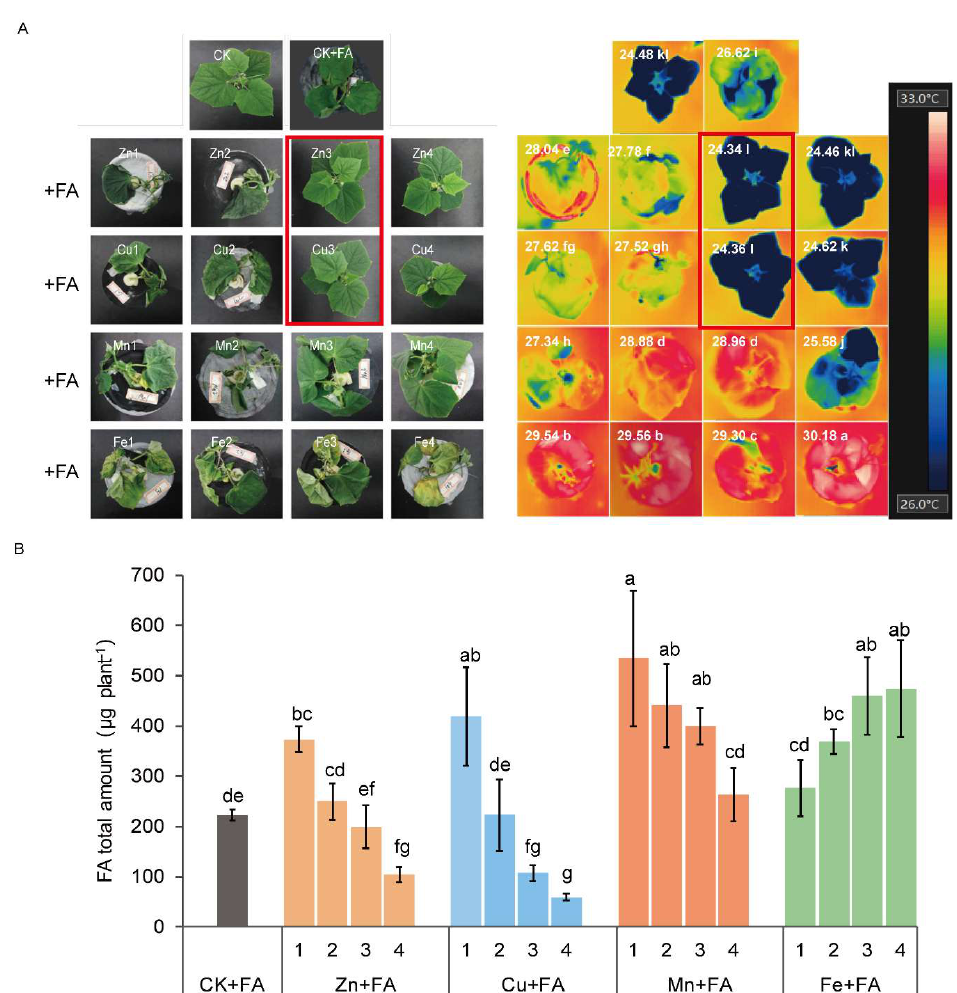
Figure 1. Effects of Fe, Mn, Cu and Zn on cucumber plants under fusaric acid (FA) supply. ( A ) 3-week-old seedlings were cultured with Hoagland solutions containing 2 µg mL −1 FA and different concentrations of Fe, Mn, Cu or Zn. CK, control plants; CK + FA, control plants after FA treatment. Each ion consists of four concentration series, denoted by 1, 2, 3, 4; Zn concentrations were 0, 9.6, 48 and 144 µM; Cu concentrations were 0, 2, 20 and 40 µM; Mn concentrations were 0, 57, 114 and 570 µM; Fe concentrations were 0, 89.5, 179 and 358 µM. The two treatments in the red box were selected for the following experiments. Thermal images of cucumber plants under light conditions after different treatments were shown on the right. The treatments directly correspond to the left. The temperature quantification results represent the means of four replicates ( ◦ C). ( B ) FA total amount in the plant with di ff erent treatments. The letters in the thermal image on the right side of figure ( A ) indicate statistically significant di ff erences ( p < 0.05) among all treatments (a total of 18 treatments). The letters above the bars of the histogram in figure ( B ) indicate statistically significant di ff erences ( p < 0.05) among all di ff erent treatments (a total of 17 treatments) and bars represent standard deviation with four